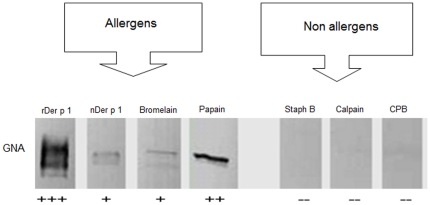
Comparative analysis of cysteine protease allergens and non-allergens in terms of mannosylation.Allergens are strongly mannosylated and have stronger reaction with anti-mannose GNA compared to non-allergens. +++: strong reaction, ++: moderate reaction, +: mild reaction, −: no reaction.